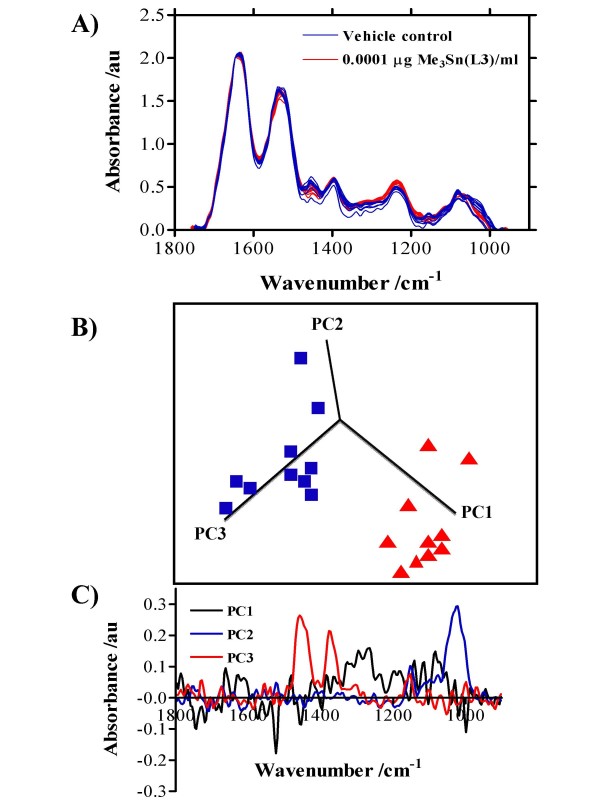
Average IR spectra of MCF-7 cells with corresponding scores plots plotted on PCs 1,2 and 3 and loadings plots following 24-h exposure to 0.0001 μg Me3Sn(L3)/ml. Cells were seeded into 60-mm Petri dishes and allowed to attach for 24 h prior to exposure. Following exposure, cells were disaggregated with trypsin/EDTA solution, fixed in 70% EtOH, and applied to Low-E Microscope slides whereupon the suspensions were allowed to air-dry. A) 10 IR spectra were derived (vehicle control in blue, treated in red). B) From subsequent multivariate analysis, a 3-D scores plot on PCs selected to demonstrate best segregation of vehicle control (blue) vs. exposure (red) was constructed. C) Following cluster analysis, loadings plots were constructed on each relevant PC to identify the wavenumbers most responsible for segregation of clusters.